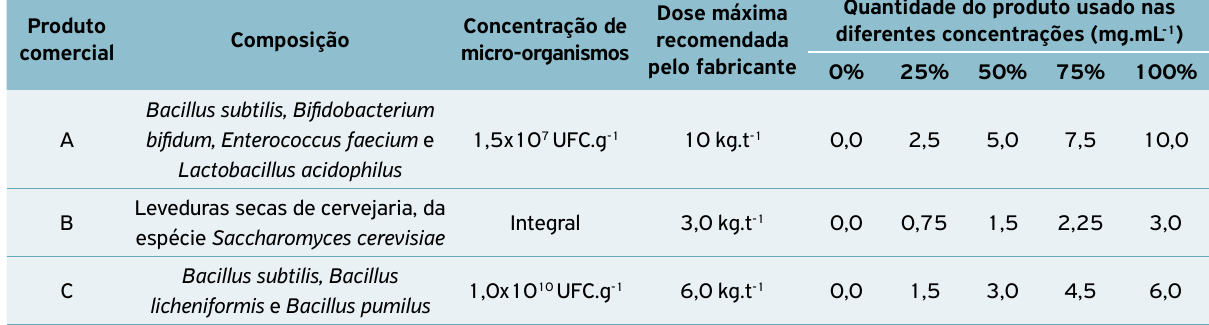
UFC: unidades formadoras de